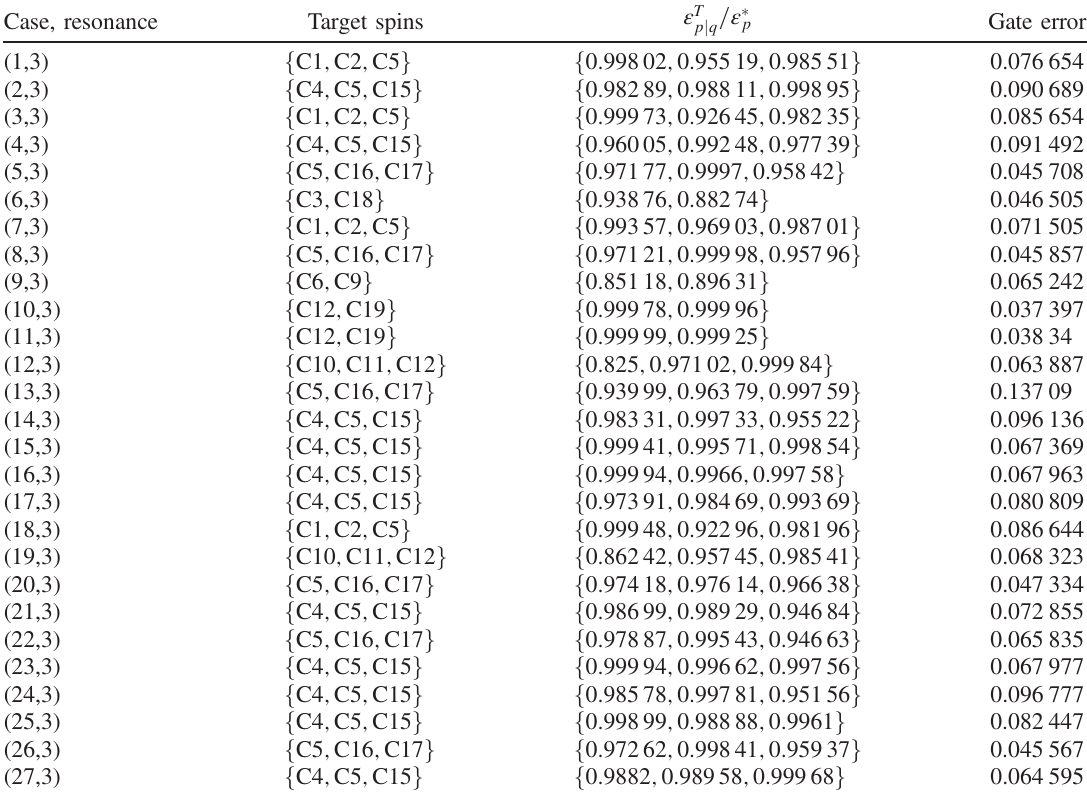
TABLE VIII. Target spins, one-tangles, and gate error for each case number for the k ¼ 3 resonance in Fig. 8. Case, resonance